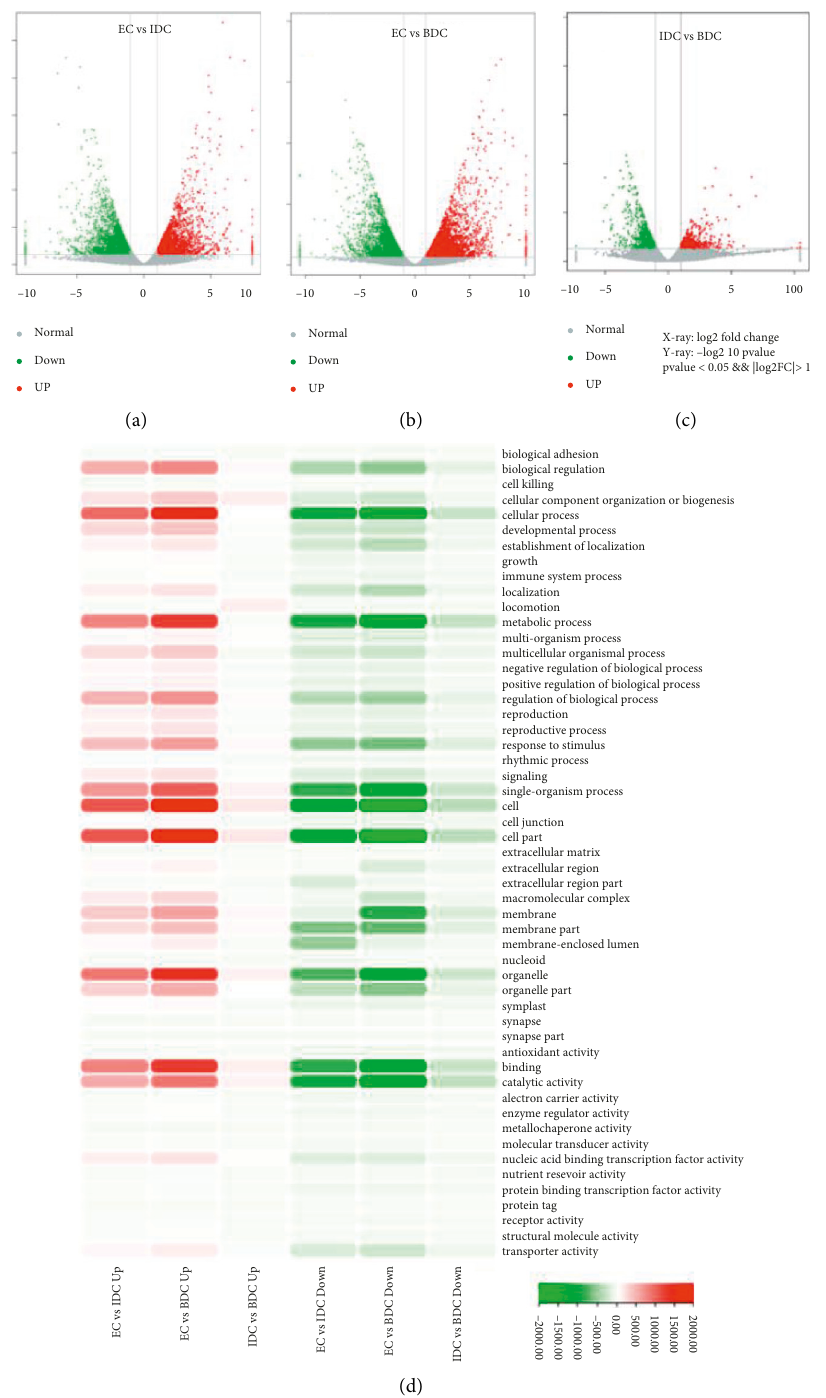
Figure 4: Identification of DEGs and Gene Ontology analysis among callus in different induction states. (a) Identification of DEGs between EC and IDC. The volcano plot presents the expression of the DEGs in different treatments, the red dots represent upregulated genes, and the green dots represent downregulated genes. (b) Identification of DEGs between EC and BDC. (c) Identification of DEGs between IDC and BDC. (d) Heat map of the gene numbers enriched of the DEGs in differential Gene Ontology. The color depth of the module represents the size of the contained genes. The darker the red, the more upregulated genes are enriched. The darker the green, the more downregulated genes are